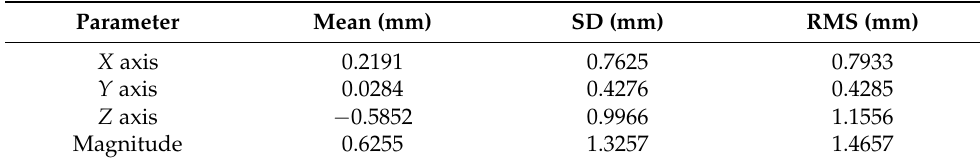
Figure 11. Snapshot of the master–slave teleoperation system experiment.